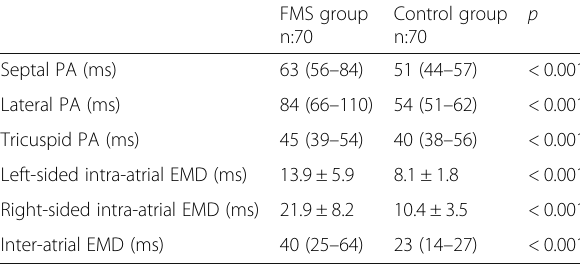
Table 3 The atrial conduction times of the FMS and control groups